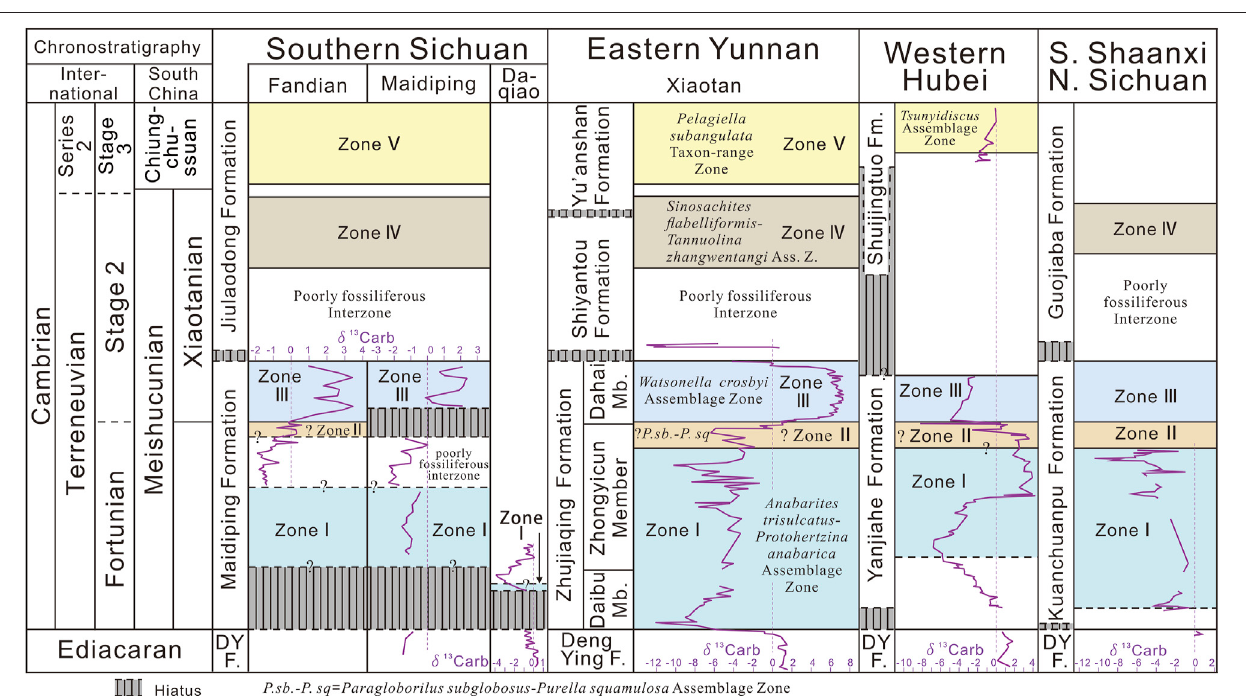
Frontiers in Earth Science |